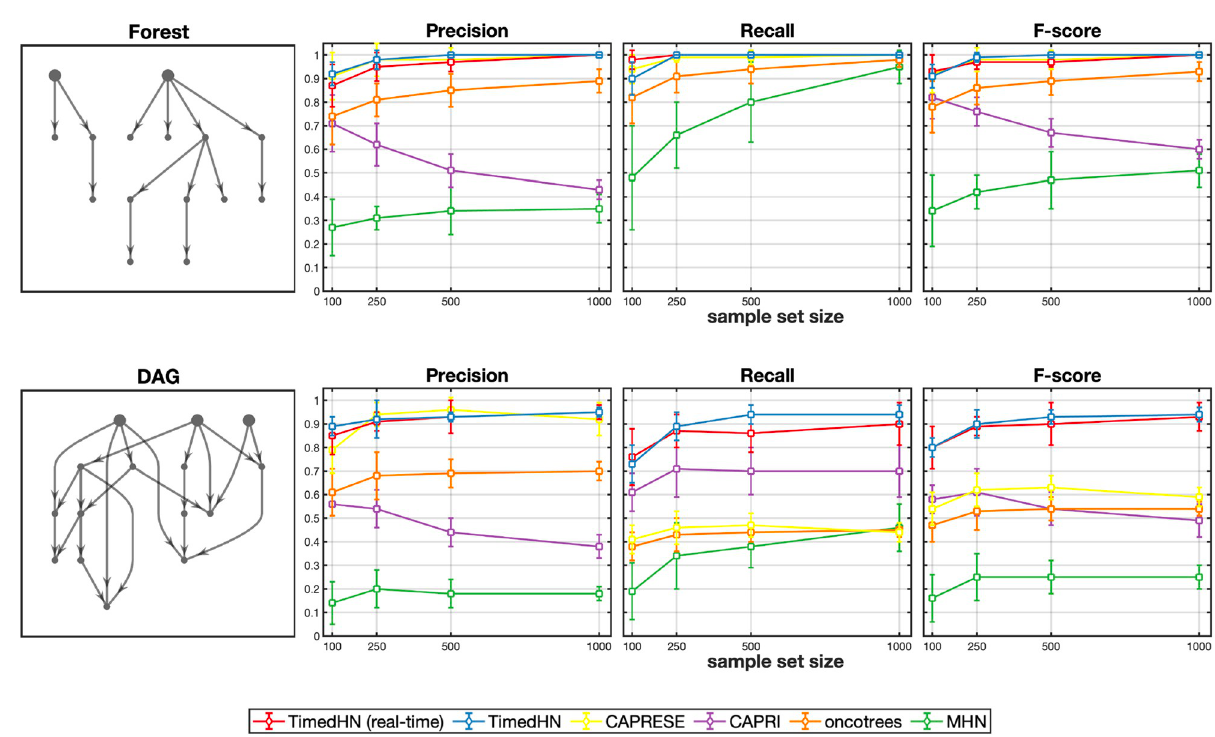
Fig 2. The precision, recall, and F-score of the six methods was compared on synthetic datasets consisting of 15 events sampled from CTMCs parameterized by forests and DAGs.